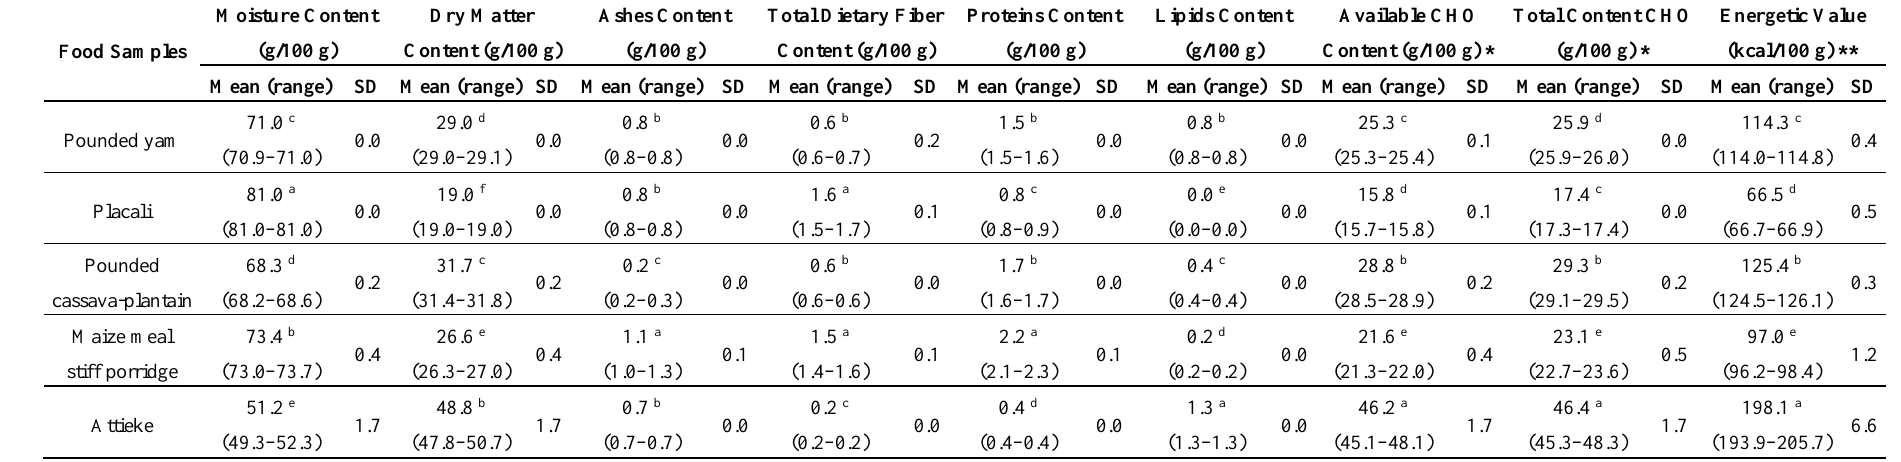
Table 2. Proximate composition of selected Ivorian starchy foodstuffs (g/100 g wet sample).